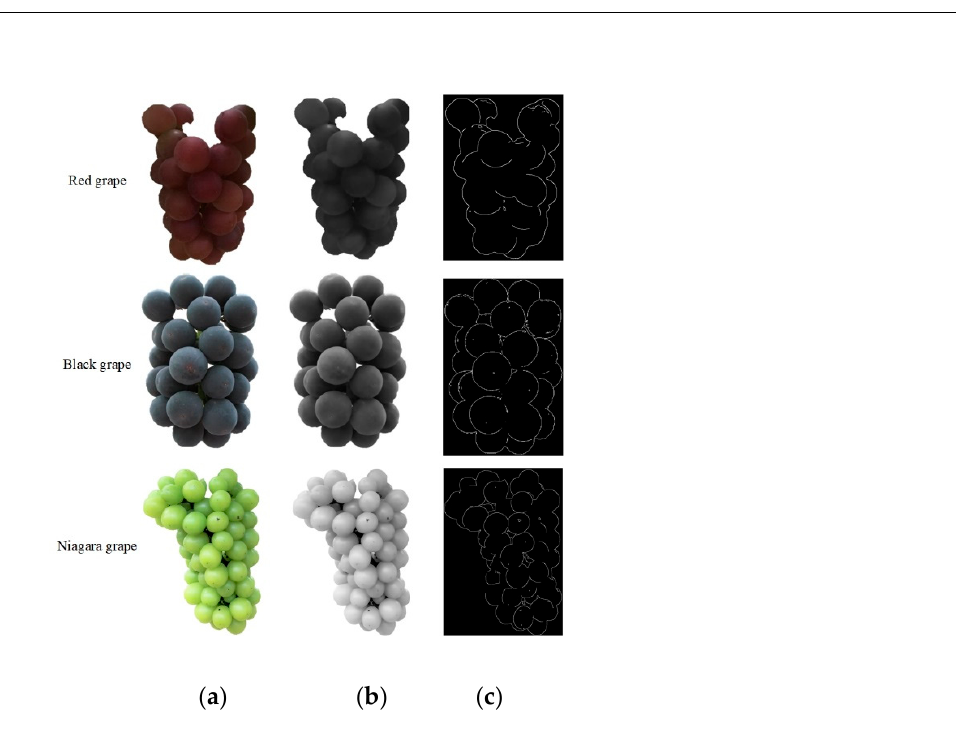
Figure 4. Image preprocessing. ( a ) stands for original image; ( b ) stands for gray image; ( c ) stands for edge information map of Canny detection.